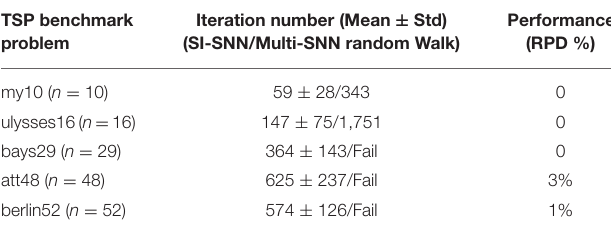
TABLE 2 | Performance of solving TSP. TSP benchmark